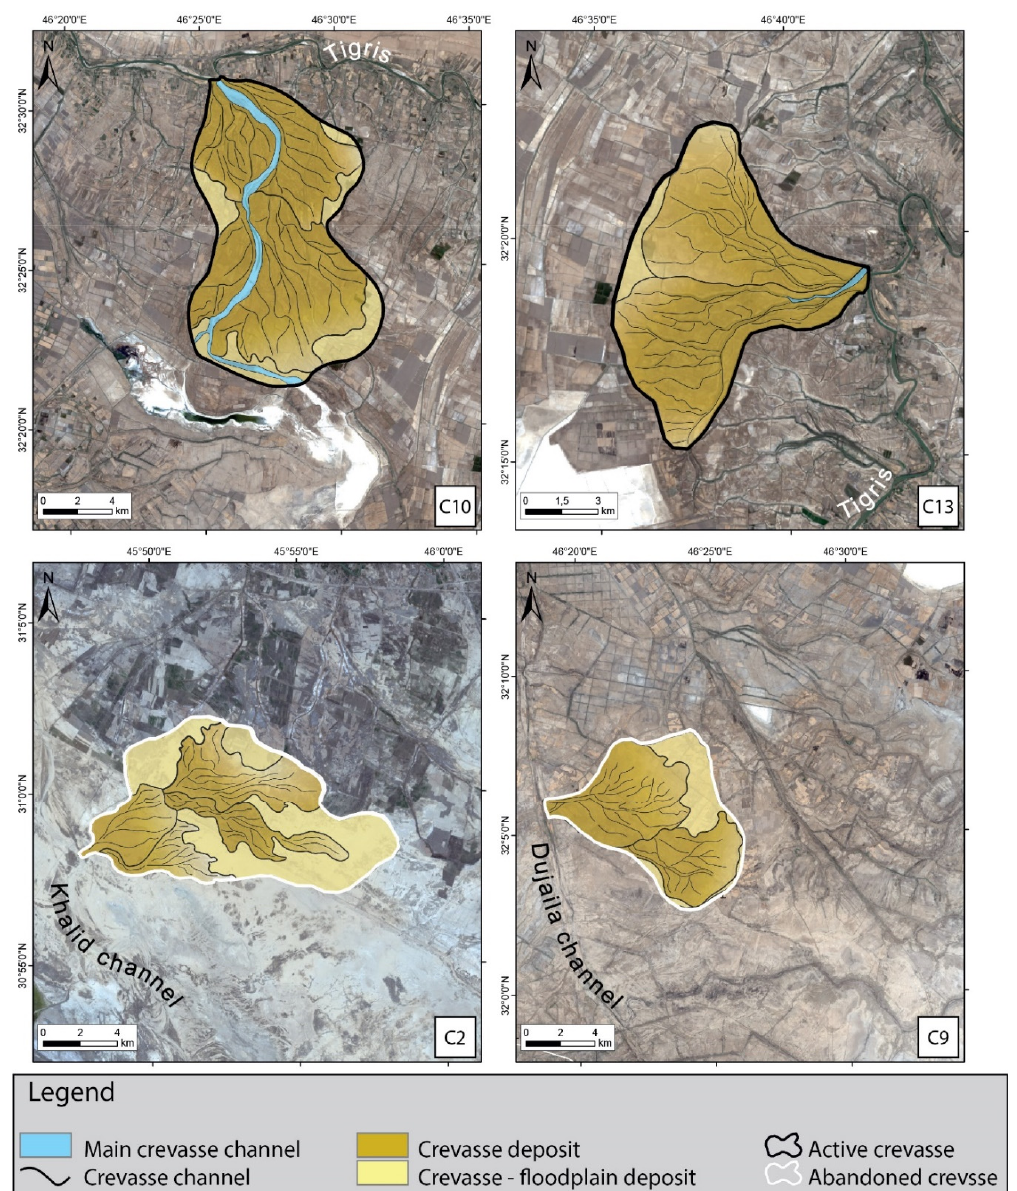
Figure 14. The re-mapping of active ( C10 and C13 ) and abandoned ( C2 and C9 ) crevasses for highlighting the hierarchy of the single flood event.